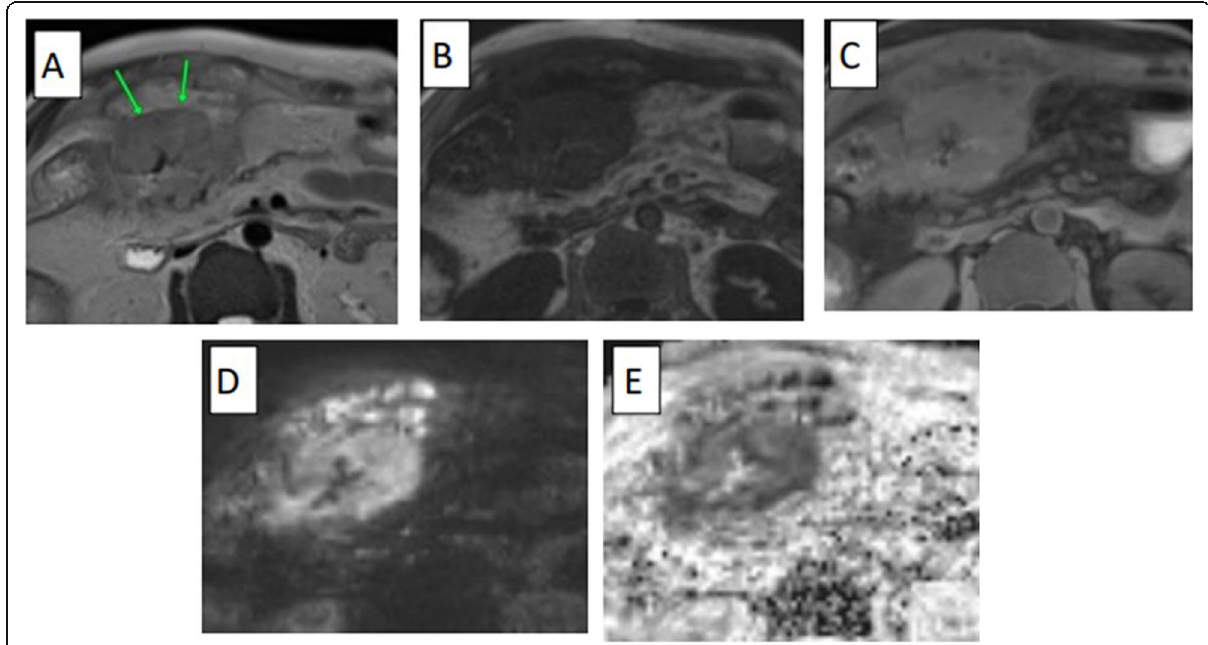
Fig. 4 Forty-year-old male presented with abdominal pain and weight loss. Colonoscopy and biopsy revealed transverse colon well-differentiated adenocarcinoma. Large lobulated circumferential soft tissue mass was seen infiltrating the right side of the transverse colon reaching the serosa with minimal extension into the surrounding fat. It displayed high to intermediate signal in T2WI ( A ) and low signal in T1WI ( B ), with heterogeneous enhancement in post contrast images ( C ). The lesion appeared bright in DWIs ( D ) and turned dark in the ADC map ( E ), with ADC value 1.1 × 10 − 3 mm 2 /s, indicating restricted